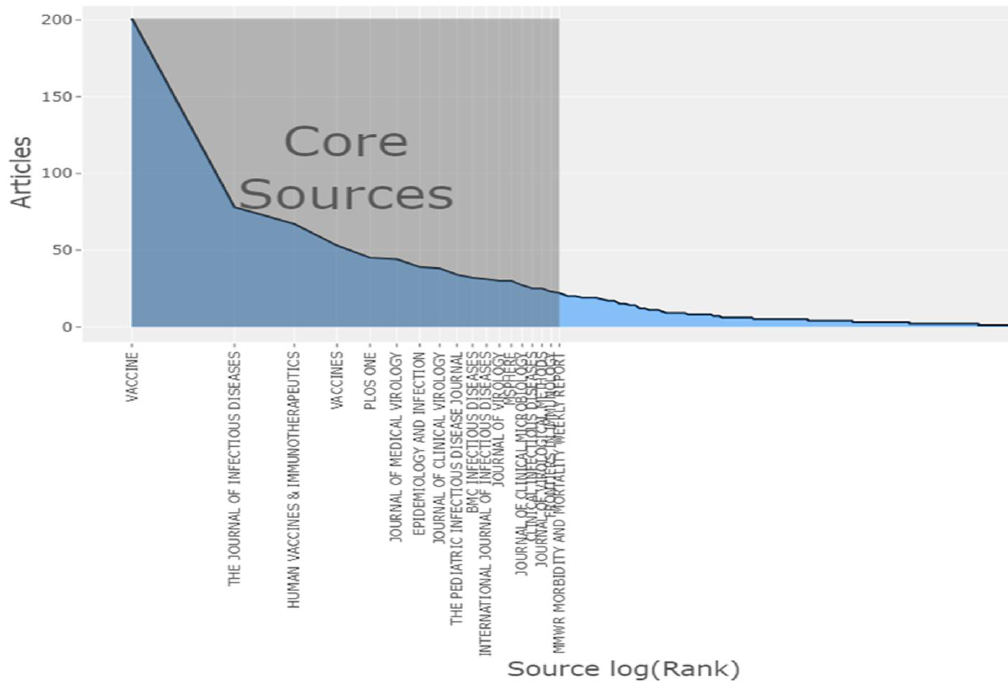
Figure 3. Source distribution by Bradford’s law.